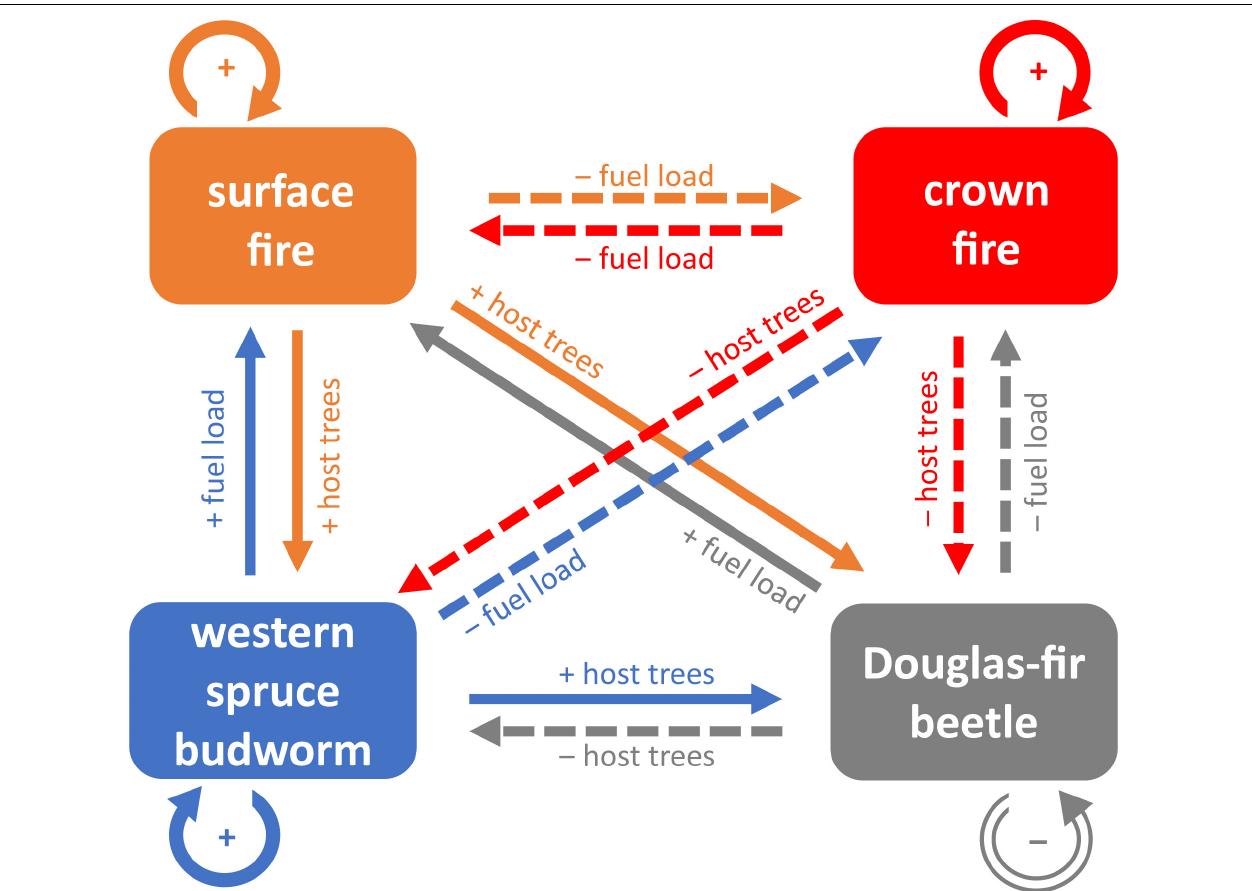
FIGURE 3 | Conceptual model of historical disturbance interactions in dry Douglas-fir-dominated forests. Solid color arrows and “ + ” symbols indicate net positive interactions between disturbances. Dashed color arrows and “ − ” symbols indicate net negative effects. Arrow colors correspond to the causal disturbance agent and point toward the affected disturbance; labels identify key mechanisms of